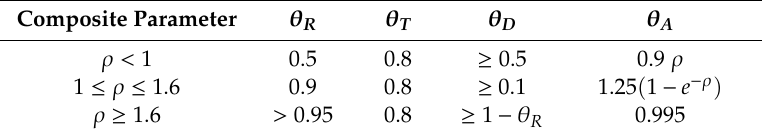
Table 1. Mukati–Ogunnaike tuning rules [4].